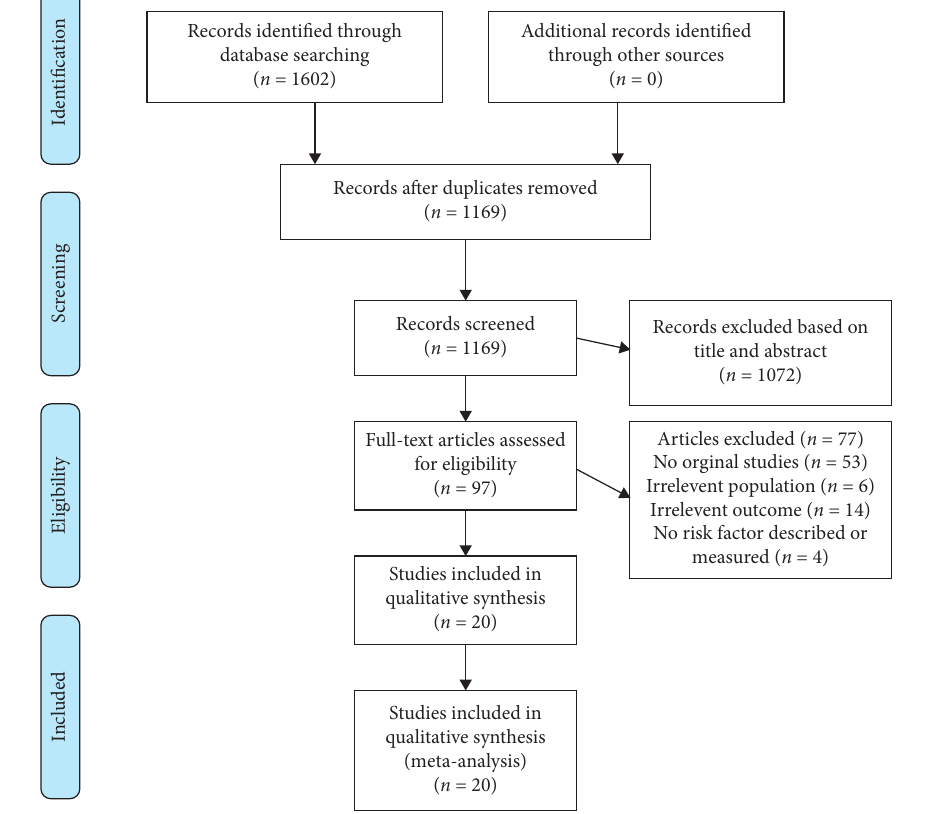
Figure 1: PRISMA flow diagram.